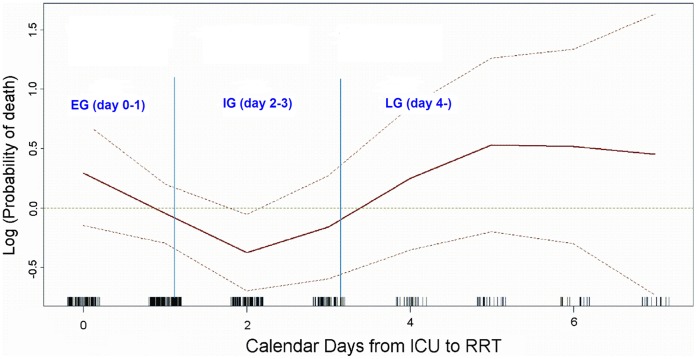
Probability of death by the calendar days from ICU admission to RRT initiation.The figure was drawn using generalized additive model. Adjusted by sex, age, diabetes mellitus, chronic kidney disease, cirrhosis, extracorporeal membrane oxygenation support, initial neurological dysfunction, as well as sepsis, mean arterial pressure, inotropic equivalent, and Acute Physiology and Chronic Health Evaluation II scores at RRT initiation. Abbreviations: EG, early group; ICU, intensive care unit; IG, intermediate group; LG, late group; RRT, renal replacement therapy.